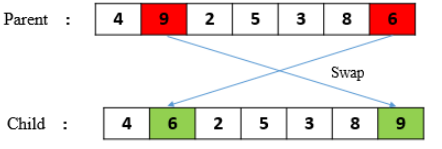
Fig. 4 An illustration for swap operation Fig. 5 An illustration for reverse swap operation